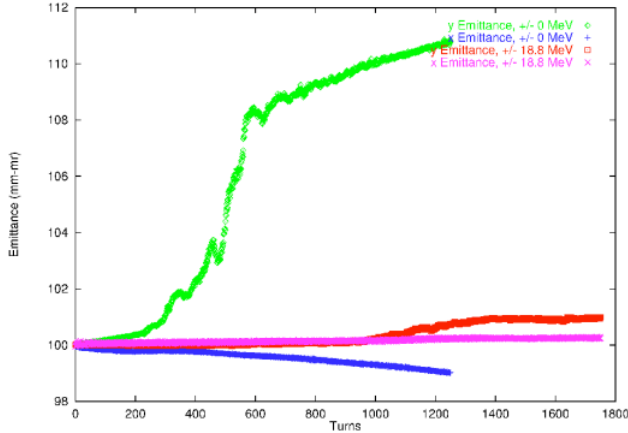
FIG. 10. (Color) Effect of dispersion and energy spread on emittance growth. Increased energy spread tends to dampen the parametric resonance instability.